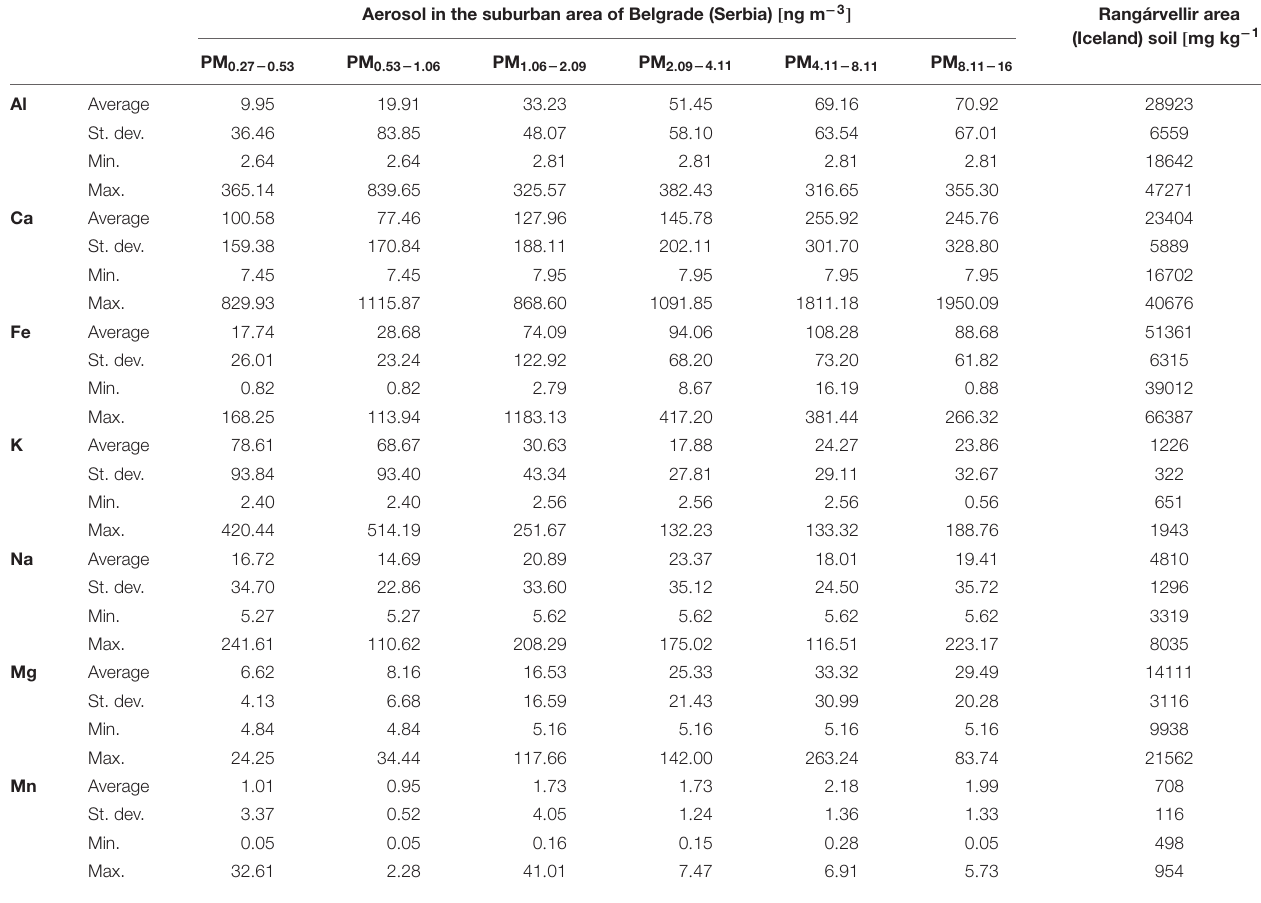
(Iceland) soil [ mg kg − 1 ]